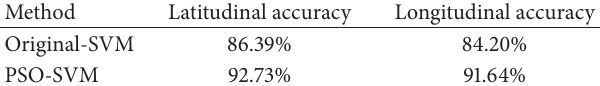
Table 2: Prediction accuracy of different methods.